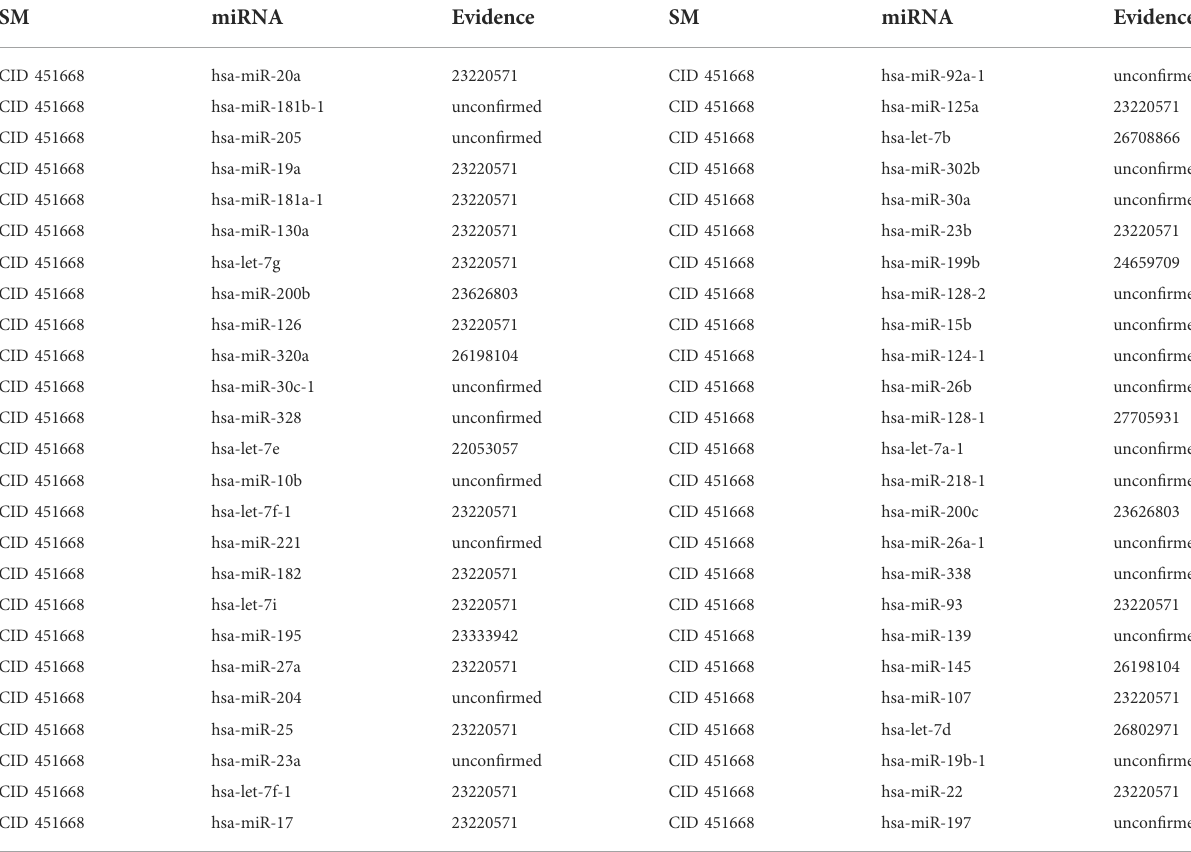
TABLE6Validationofthetop50miRNAsassociated with5-Aza-CdRinthesecondtypeofcasestudies.The fi rstcolumnrecordsthetop1 – 25related miRNAs. The second column records the top 26 – 50 related